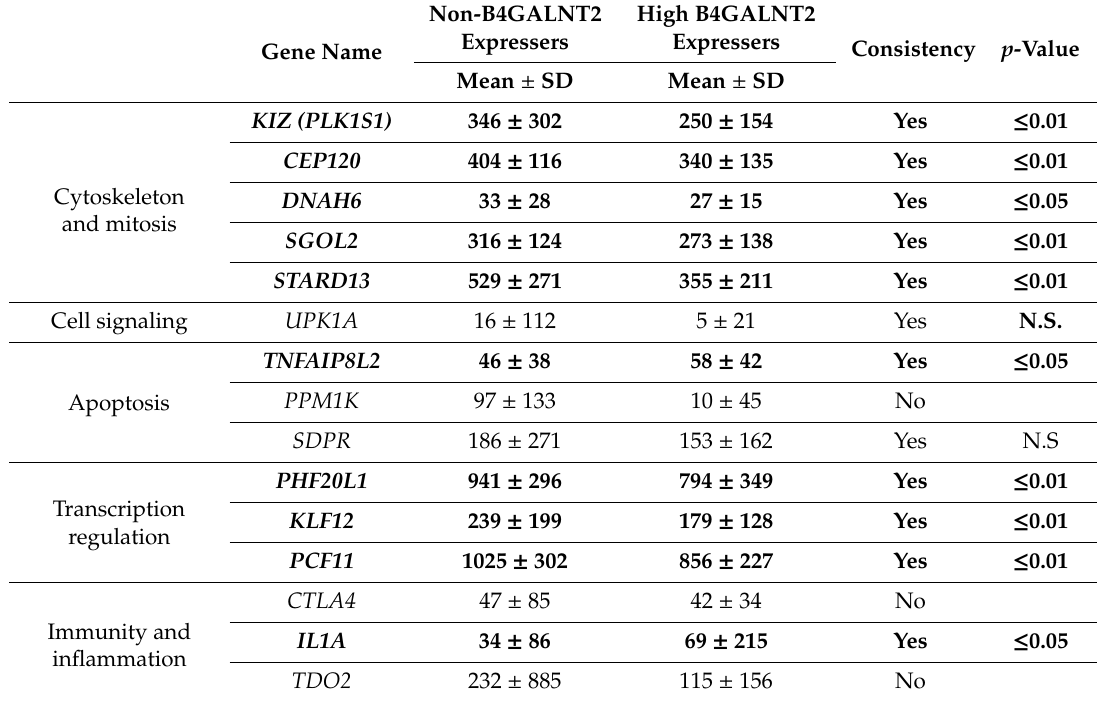
Table 6. Gene expression comparison between TCGA cohort (Non- and High B4GALNT2 expressers and microarray analyisis of LS174T cells (modulated by 3D only in S2 /